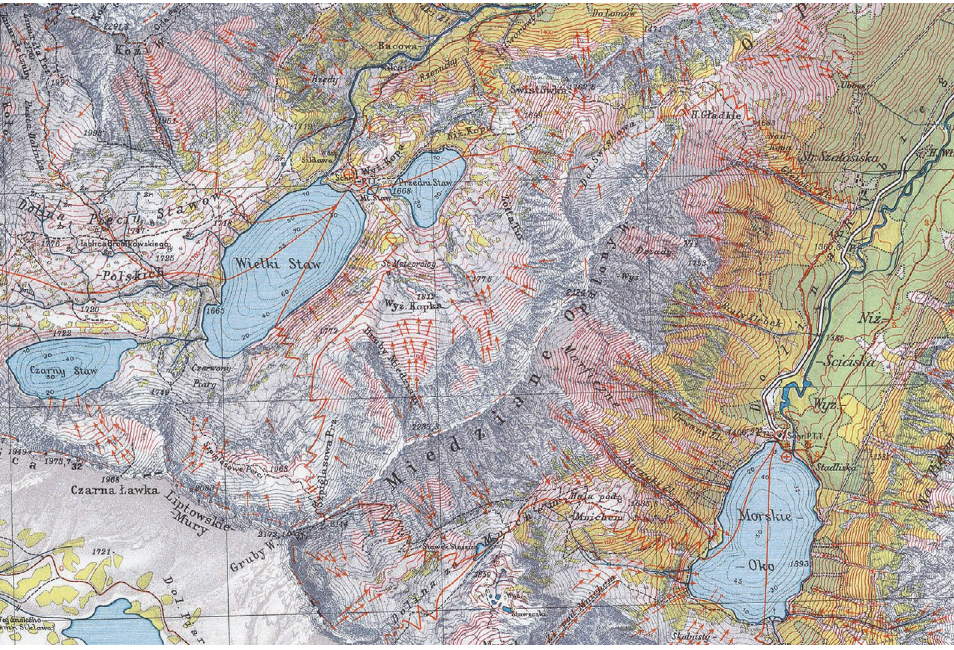
Fig. 1. A part of topographic map of the Tatra Mts. compiled using aerial photographs in the